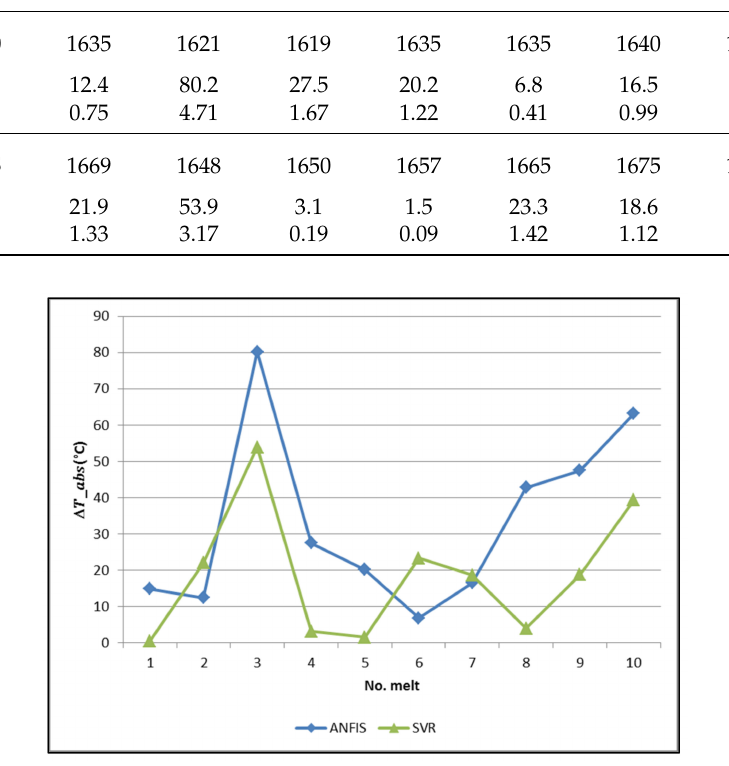
Figure 9. Absolute deviation of temperature for machine learning model. Table 5. Average absolute and relative deviation of